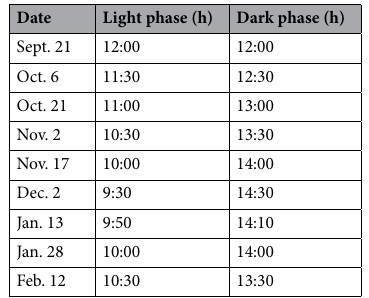
Table 4. Changes in daylength at the DLC to approximate North Carolina, USA photoperiod.